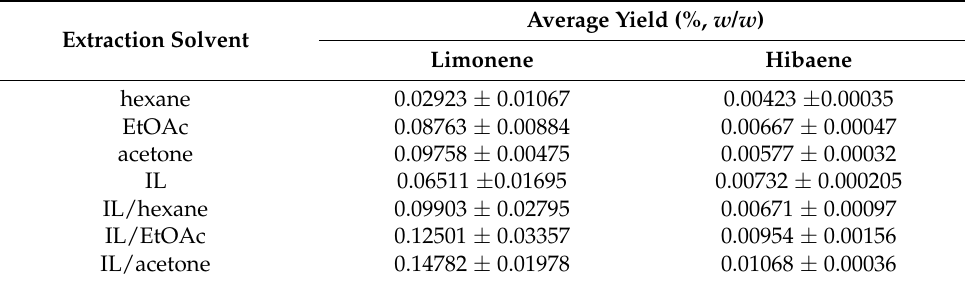
Table 1. Extraction yields for limonene and hibaene ( n = 3).